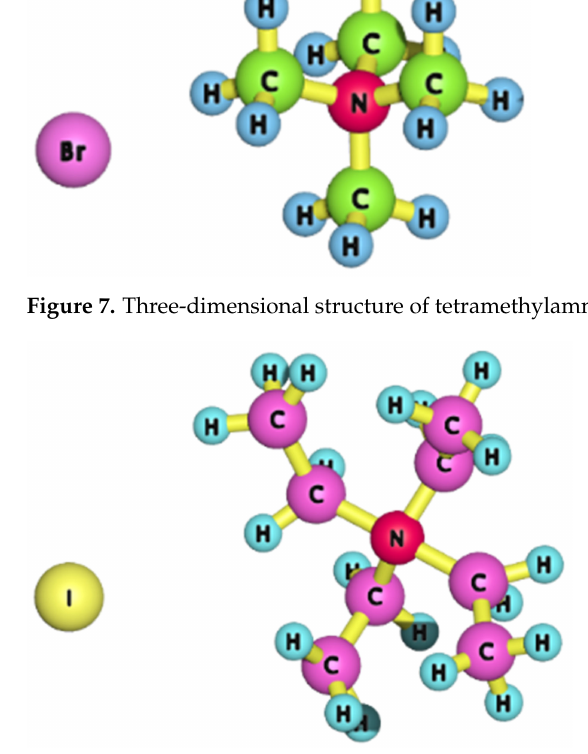
Figure 8. Three-dimensional structure of tetraethylammonium iodide